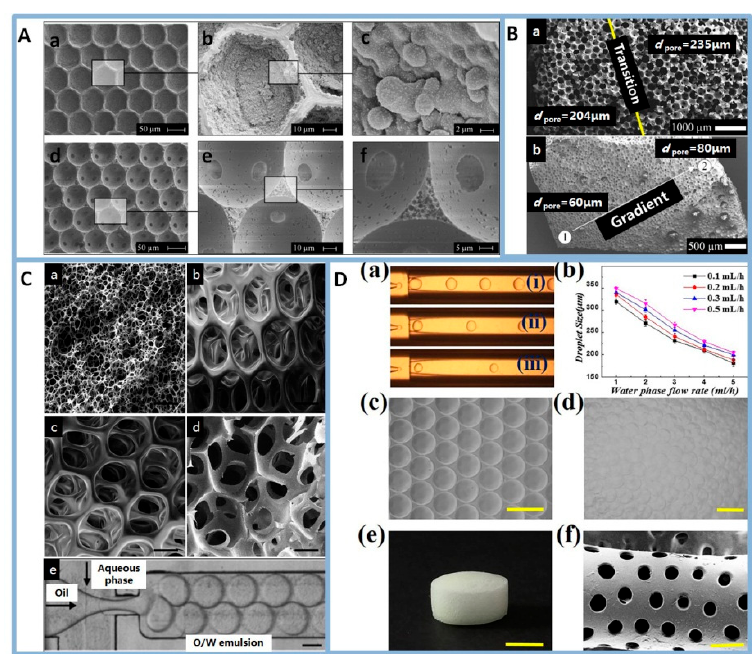
Figure 5. ( A ): SEM pictures of polymer foams with the locus of initiation being at the o/w interface using potassium persulfate (KPS) (a–c) or in the bulk phase using azobis-(isobutyronitrile) (AIBN) (d-e) at different magnifications. Reprinted from [82] with permission. Copyright 2017 American Chemical Society. ( B ): Polystyrene foams with a pore size and density gradient from foamed emulsion templating (a) and emulsion templating (b). Reprinted from [80] with permission. Copyright 2017 Wiley. ( C ): SEM micrographs of scaffolds fabricated through (a) conventional HIPE formation and (b–d) microfluidics. (e) Optical micrograph of the flow focusing chip, the scale bars measure respectively (a) 30 μ m, (b–e) 100 μ m. Reprinted from [83] with permission. Copyright 2014 Royal Society of Chemistry. ( D ): (a) Real-time image of the droplet template in the microfluidic device with different inner and outer flow rates, (b) the relationships of the pore size to the outer flow rates and the inner flow rates, (c,d) microscopic photographs of the monolayer droplet and multilayer droplets, (e) a general view of the porous scaffold, (f) the microstructure of the porous scaffold that fits the rat uterus, scale bars measure respectively (c,d,f) 500 μ m and (e) 5 mm. Reprinted from [51] with permission. Copyright 2019 Elsevier.